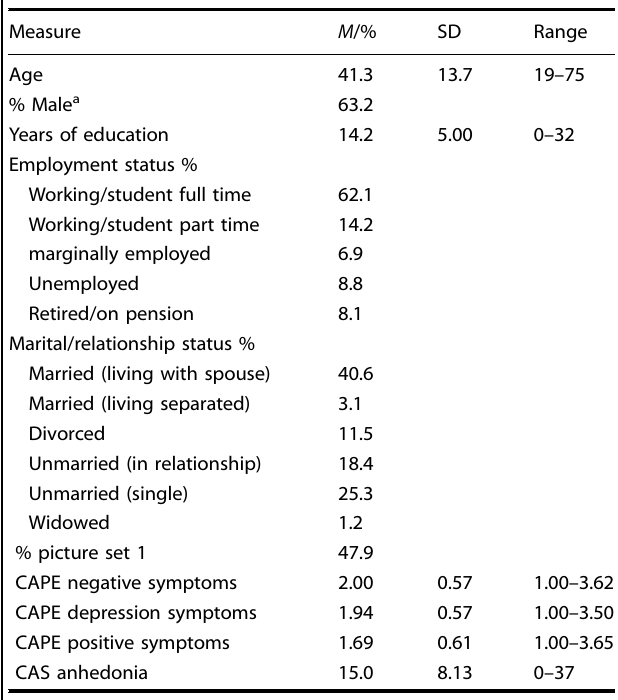
negativity: Table S8, arousal: Table S14). For all three response Table 1. Sample characteristics ( N =